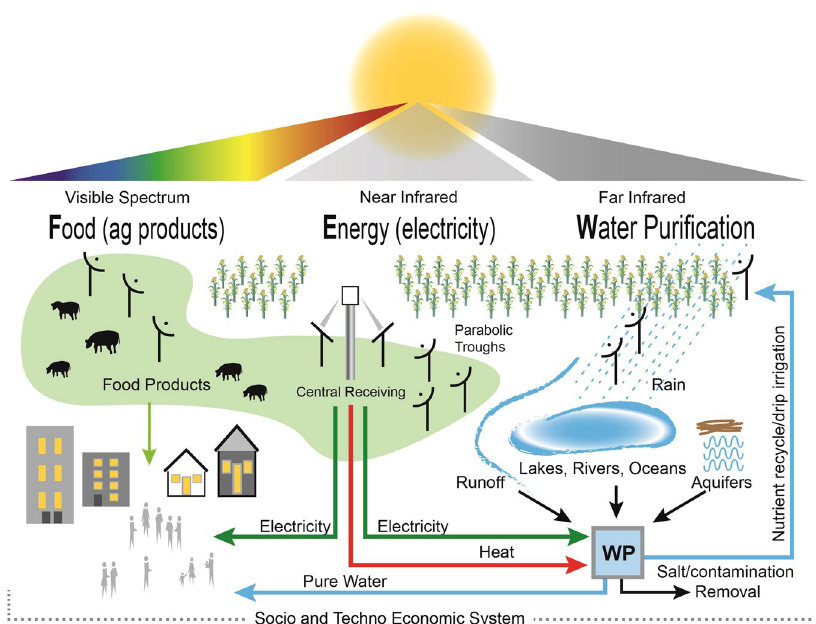
Figure 3. Conceptual implementation of SUFEWS in which photons are managed efficiently over crop/pasture land to simultaneously and harmoniously produce FEW products in a sustainable future for a Full Earth. (Figure credit: Pamela Burroff-Murr, Purdue